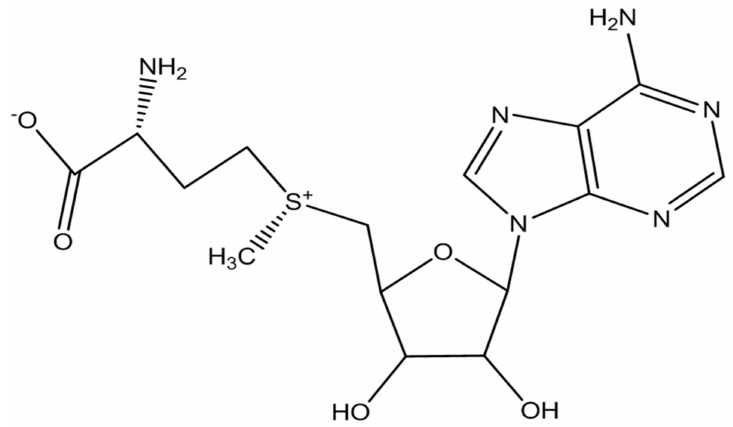
Figure 1. Chemical structure of SAMe